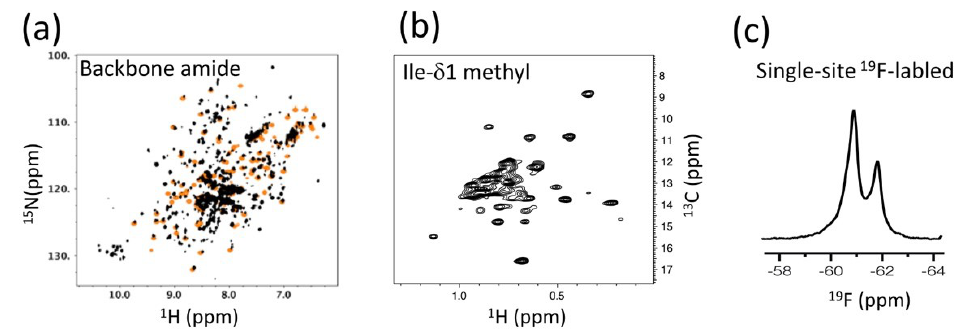
Figure 4. NMR strategies used to investigate RT: ( a ) an example of a 1 H- 15 N TROSY HSQC spectrum, used to compare p66 with those of isolated domains; ( b ) an example of an Ile- δ 1 methyl 1 H- 13 C HMQC spectrum, used for comparison of the different states of p66/p66; and ( c ) a one-dimensional 19 F NMR spectrum of a single-site labeled p66/p66. In panel ( a ), HSQC signals from an isolated RNH (orange) are overlaid as an example.